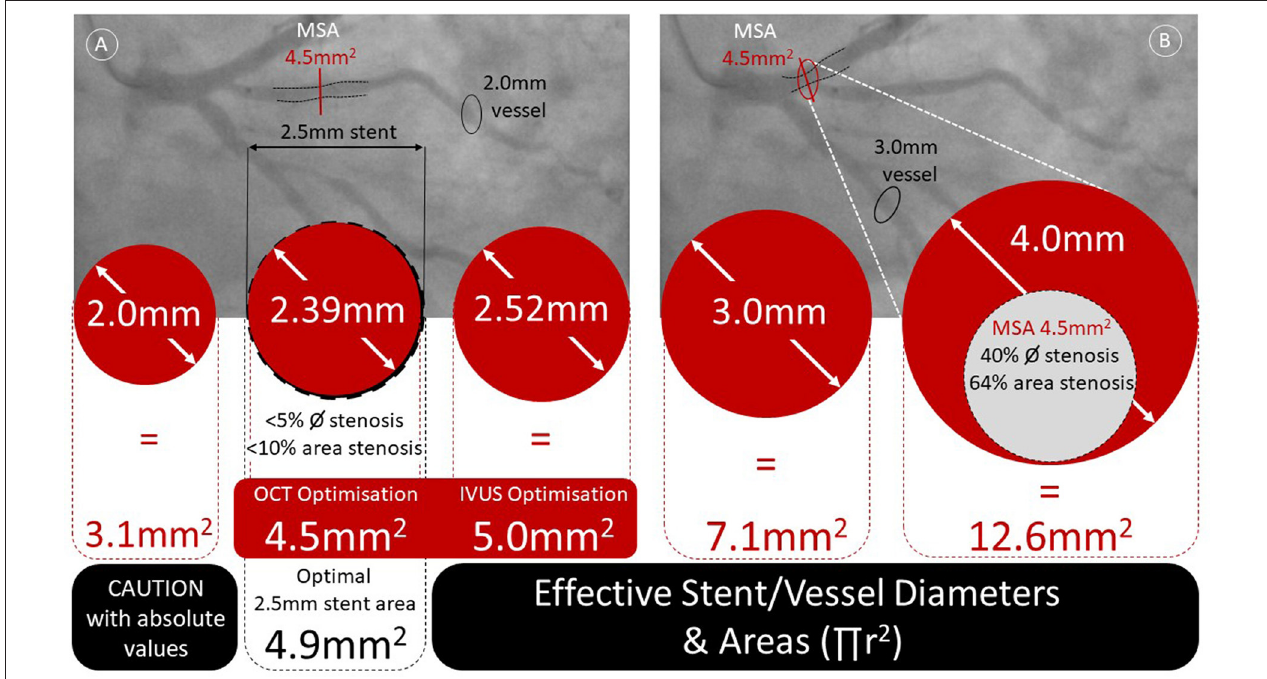
FIGURE 4 | Understanding the relationship between lumen diameter and area with reference to OCT and IVUS optimization criteria. Panel A—demonstrates a 2.5mm stent (black dotted lines) deployed in a high diagonal branch of the LAD with a minimal residual stenosis angiographically and 2.0mm distal reference. The 4.5 mm 2 OCT threshold for optimized stent deployment equates to a 2.39mm diameter circular vessel ( < 5% diameter stenosis and < 10% persisting area stenosis). Panel B—considers a stent (black dotted lines) deployed in the proximal LAD achieving an OCT estimated minimal stent area of 4.5 mm 2 . The reference vessel diameter of 4mm equates to a vessel area of 12.6 mm 2 and therefore the 4.5 mm 2 threshold results in a persisting diameter stenosis of 40% and area stenosis of 64%).